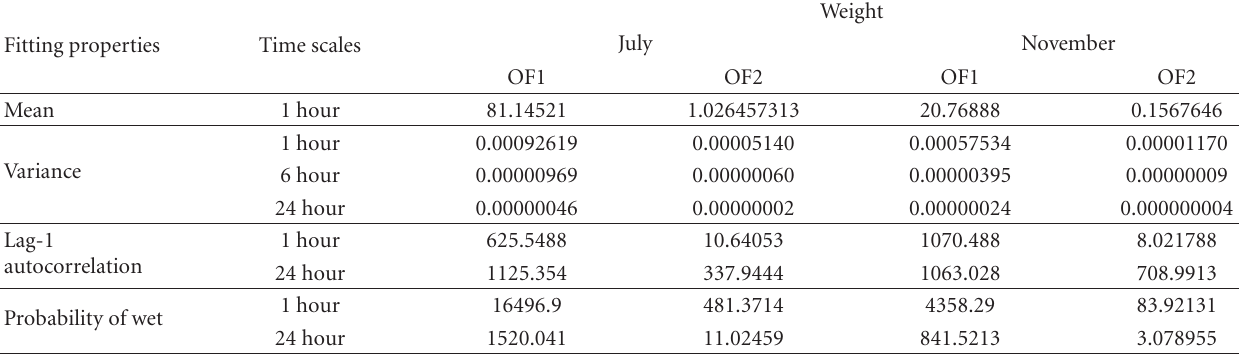
Table 1: Fitting properties and weights for the two objective functions for July and